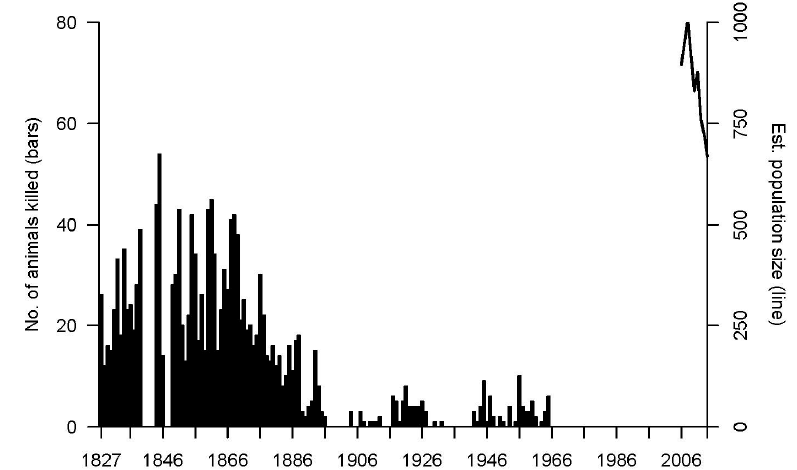
Figure 6. Number of bears killed 1827 to 1965 (no data available for 1840–1843 and 1847–1848) in Jämtland (bars). Estimated population size of bears from 2006–2014 in Jämtland (line). Sources: Swedish National Forest Service and the County Boards of Jämtland. Please note the different scales on the y-axes and that the bounty data end in 1965 and population estimates start in 2006.